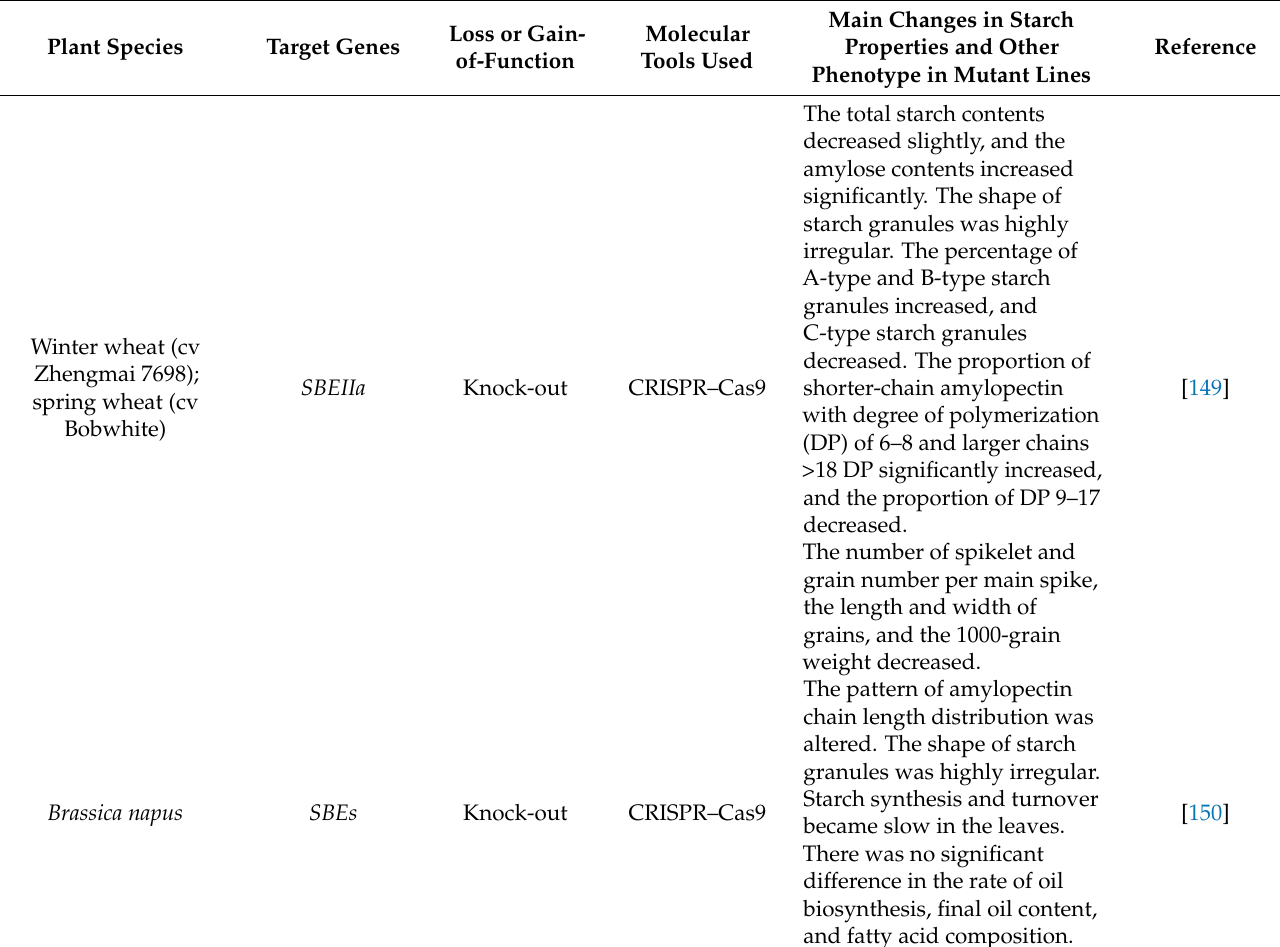
Table 4. Modulation of starch composition, structure and properties in cereal crops through genetic engineering